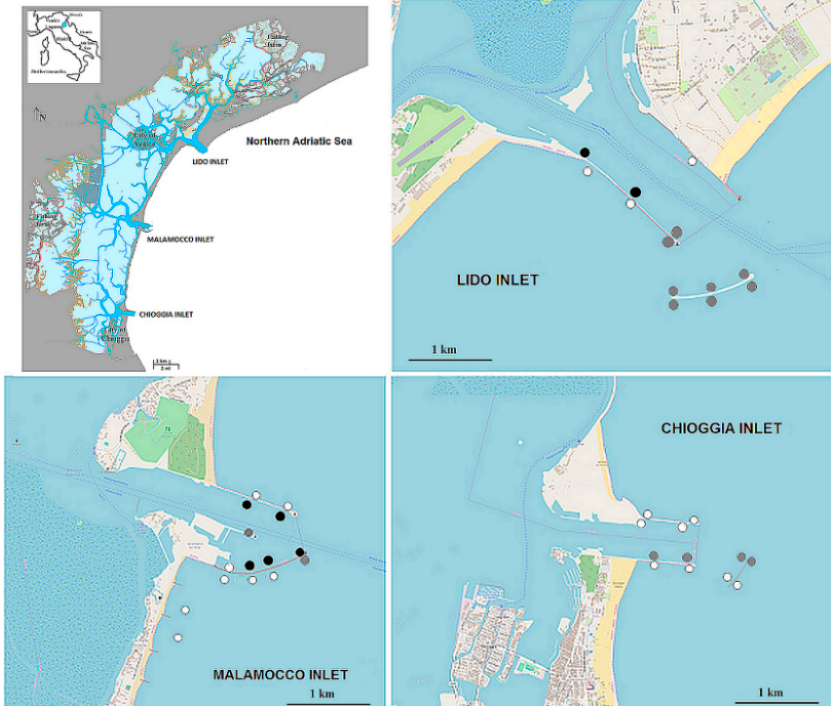
Figure 1. Map showing the 40 listening points in the three inlets (Lido, Malamocco, and Chioggia) explored during the acoustic monitoring. The map also visualizes the stations characterized by higher Sciaena umbra vocalization rates with different colors (black dots for group 1 and dark grey dots for group 2), whereas white dots indicate stations characterized by lower vocalization rates (group 3), in accordance with the results presented in this